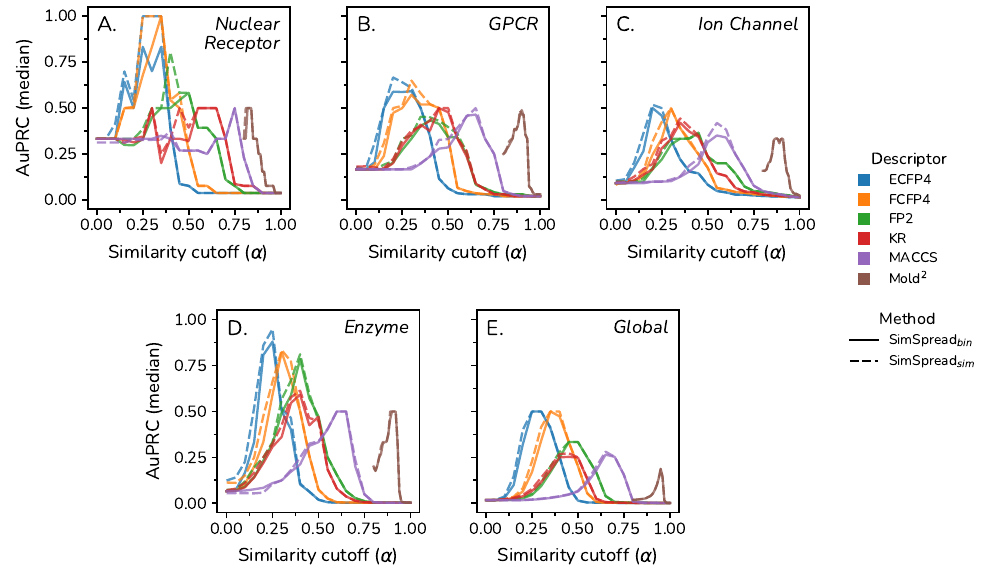
Figure 2. SimSpread parameter optimization. Median AuPRC obtained for LOOCV over five datasets for different α values. Datasets: ( A ) Nuclear Receptor, ( B ) GPCR, ( C ) Ion Channel, ( D ) Enzyme, and ( E ) Global. A total of six different molecular descriptors were tested for method optimization: ECFP4 (blue), FCFP4 (orange), FP2 (green), KR (red), MACCS kys (pur- ple) and Mold 2 (brown). Solid lines correspond to SimSpread bin while dashed lines correspond to SimSpread sim . Charts for other performance metrics and cross-validation schemes are available from the Figures S2 and S4.